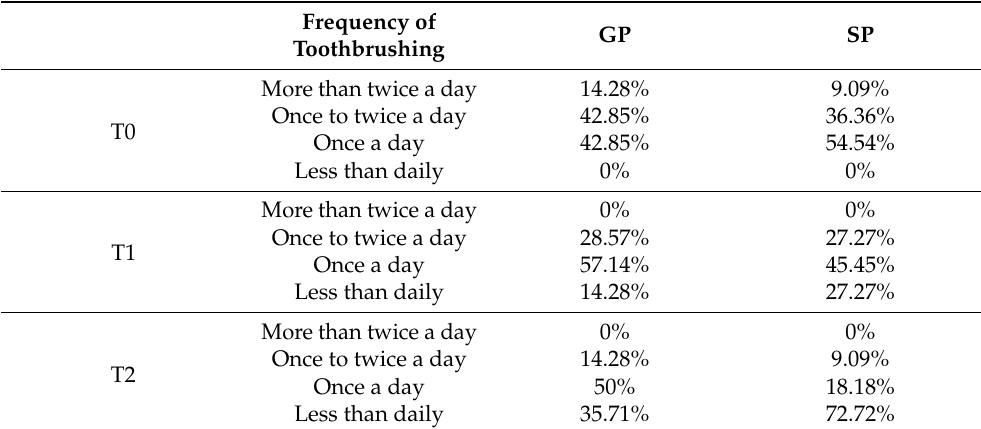
Table 5. Oral hygiene habits.